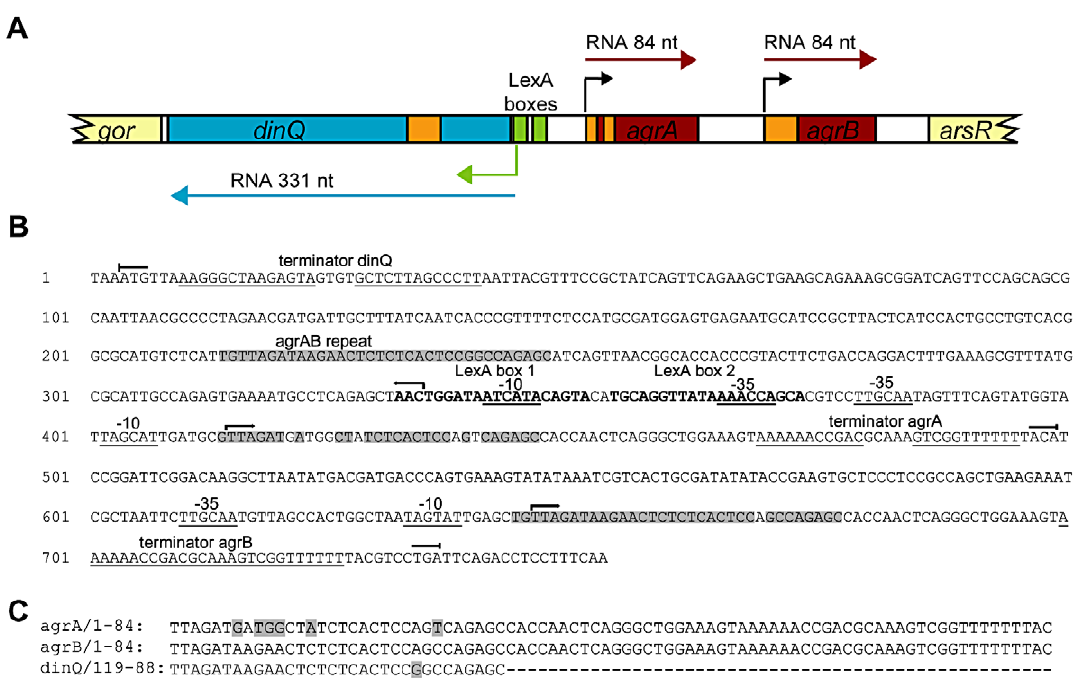
Figure 1. Overview of the dinQ / agrAB locus. (A) Genomic organization. The locus contains three genes originating from separate promoters; two constitutively expressed transcripts, agrA and agrB (red box), and one divergently transcribed gene, dinQ (blue box), which is regulated by LexA repressor binding sites (green box). Transcription initiation sites are indicated by color-coded arrows. Antisense sequences are annotated in orange. Flanking genes are indicated in light yellow. (B) Sequence of the full length arsR-gor intergenic region with hallmarks. Promoter elements, 2 10 and 2 35 and terminator sequences are underlined. LexA operator sequences in bold. Transcription start ( ) and stop ( ) for dinQ , agrA and agrB . AgrAB repeat sequences are shadowed. (C) Alignment of agrA/agrB sequences antisense to dinQ . The agrAB repeat of dinQ is antisense to sequences in the agrA and agrB transcripts.